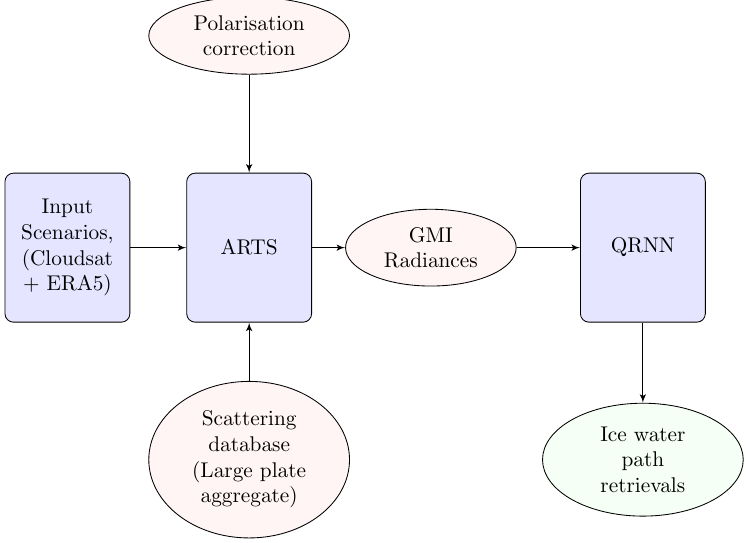
Figure 2. The flowchart showing the retrieval